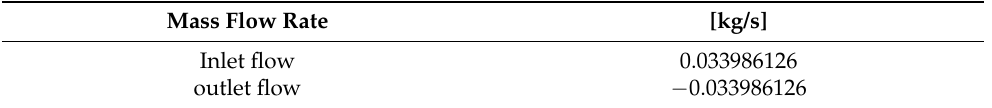
Table 1. Mass flow rate from Helical water jacket.